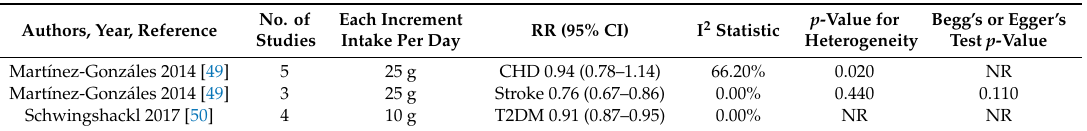
Table 8. Summary of linear dose-response meta-analyses of prospective studies on olive oil intake and CHD, stroke,